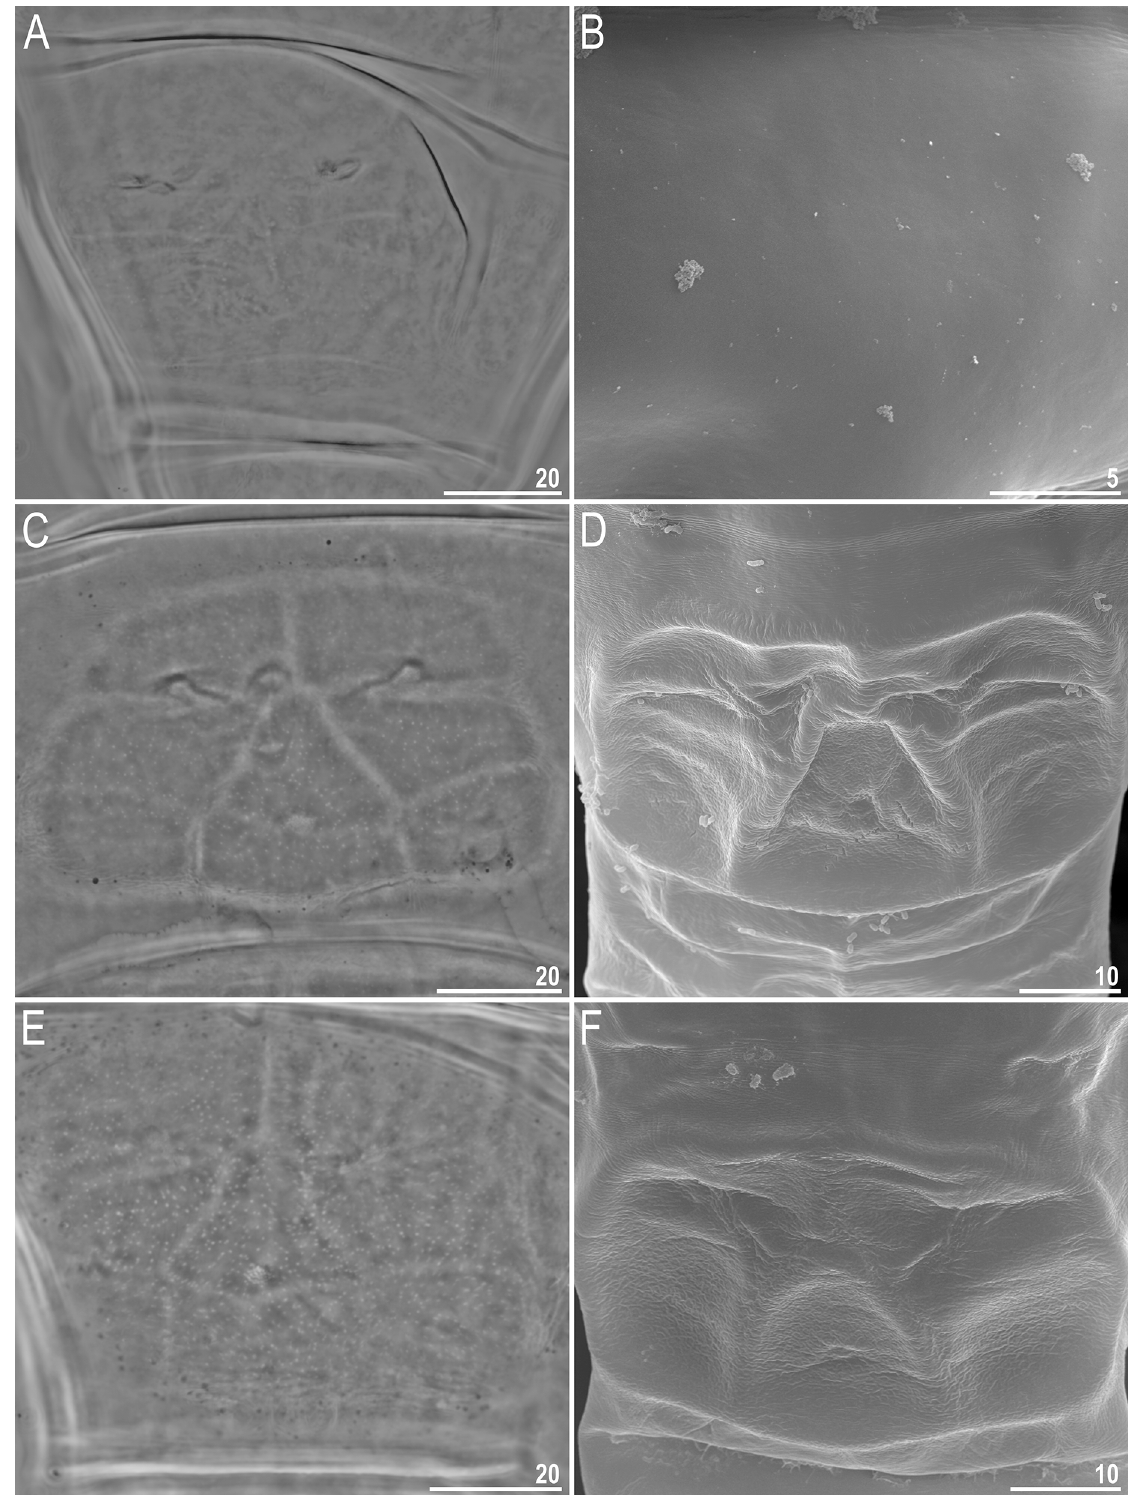
Figure 5. Examples of cuticle morphology of the Milnesium tardigradum morphogroup. ( A ) dorsal cuticle of M. tardigradum , with barely visible pseudopores, PCM; ( B ) smooth dorsal cuticle of M. tardigradum SEM; ( C ) dorsal cuticle of M. variefidum , with well-visible but tiny pseudopores, PCM (holotype); ( D ) dorsal cuticle of M. variefidum with wrinkles on pseudoplate VIII, SEM; ( E ) dorsal cuticle of M. beasleyi , with large and well-visible pseudopores, PCM (paratype); ( F ) dorsal cuticle of M. berladnicorum , with fine reticulum-like sculpturing on pseudoplate VIII, SEM. All scale bars in